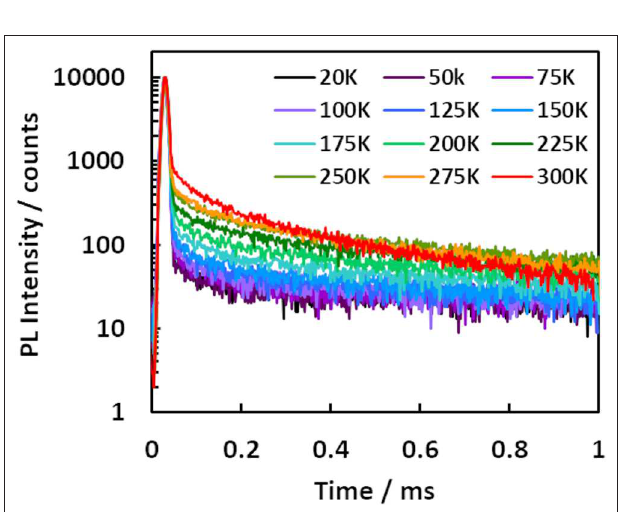
HOMO level ( − 5.73 eV) than those of 5 and 6 ( − 5.85